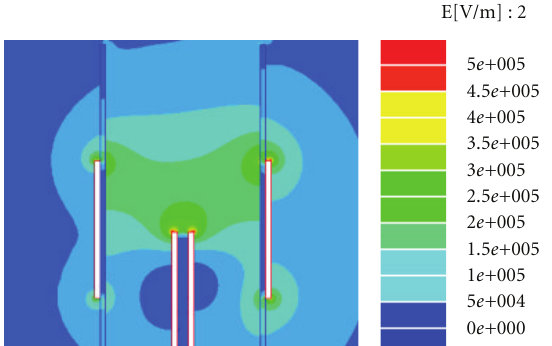
Figure 13: Metal